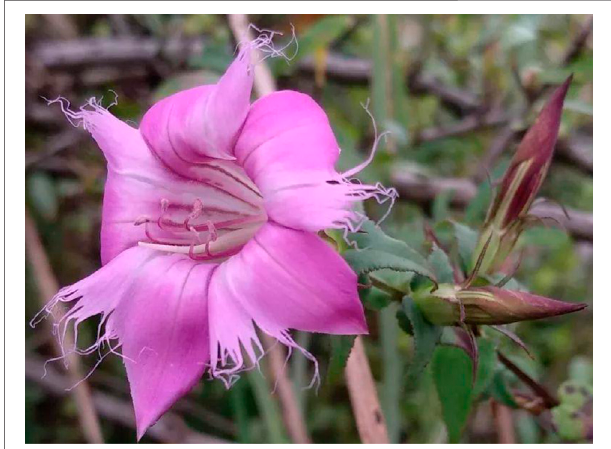
FIGURE 1 | Image of Metagentiana rhodantha (Franch.) T.N.Ho and